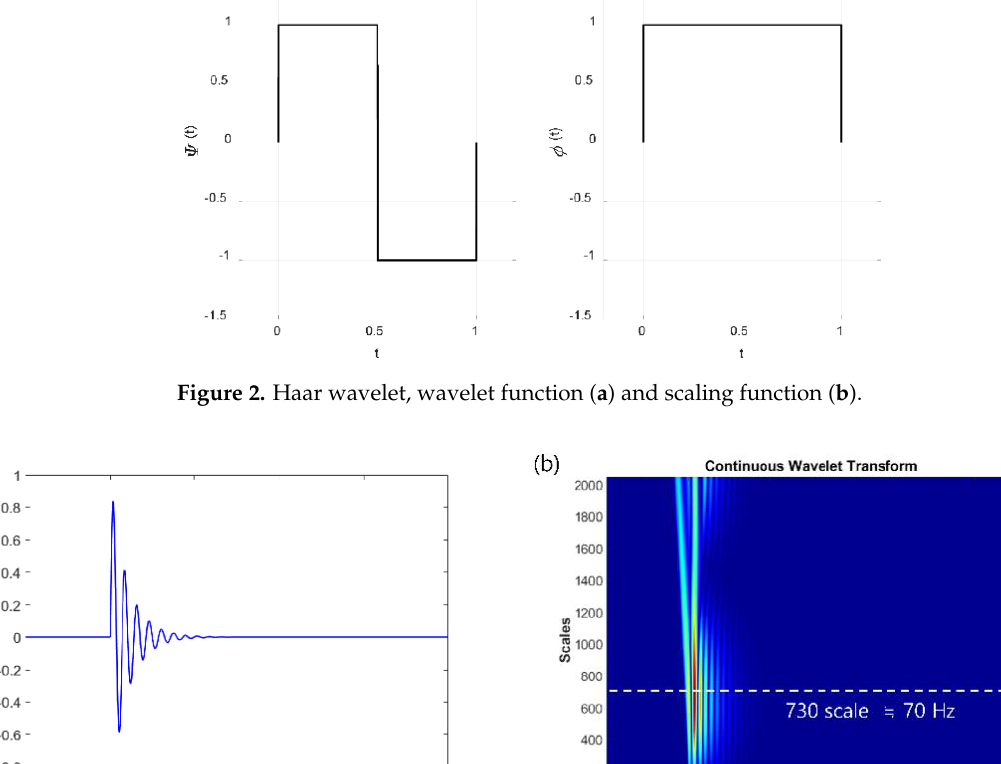
Figure 4. An impact signal with white noise (SNR: − 30 dB) ( a ) and its continuous wavelet transform ( b ); the blue line in ( a ) is the same signal as in Figure 3a. Burst noise is also prevalently observed in a vibration signal with accompanying white and banded noises. Here, a transient refers to any abrupt change that briefly stays positive or negative. Figure 5a shows an example of a burst noise model following the coupled wave signal. Even though the shape looks quite extreme, substantial burst noise can be generated from minor pressure changes in conjunction with various anomalies, such as irregularity in the pipe and discontinuities. The burst noise has features similar in CWT to the waveform of the coupled wave. In other words, the burst noise has a sharp modulus and temporally local ridges across the scales, like the coupled wave signal in CWT [19]. However, this noise has an obviously distinguishable feature from the coupled wave signal that we are looking for. The abrupt change of burst noise gets larger as the scale increases, but the signal of a coupled wave has a maximum modulus with respect to a certain scale band of the corresponding system, as shown in Figure 5b. It is worth not-